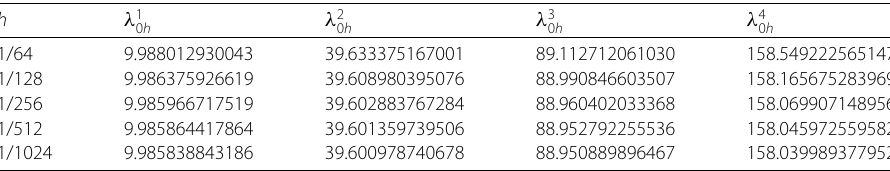
Table 7 a > 0, the four eigenvalues with l = 0 and h